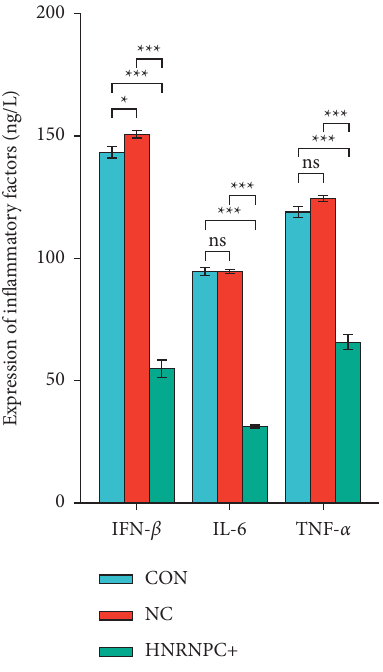
Figure 7: The effect of overexpression of HNRNPC on the ex- pression of inflammatory factors in each group. CON: control group, NC: empty plasmid group, HNRNPC+: overexpression HNRNPC group.